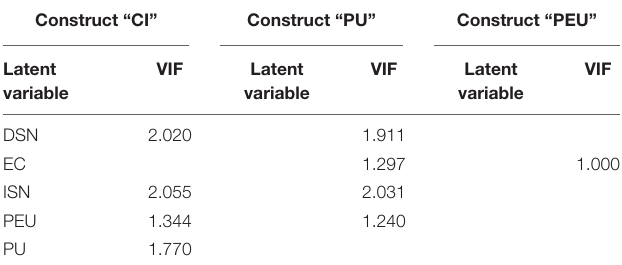
TABLE 6 | Variance inflation